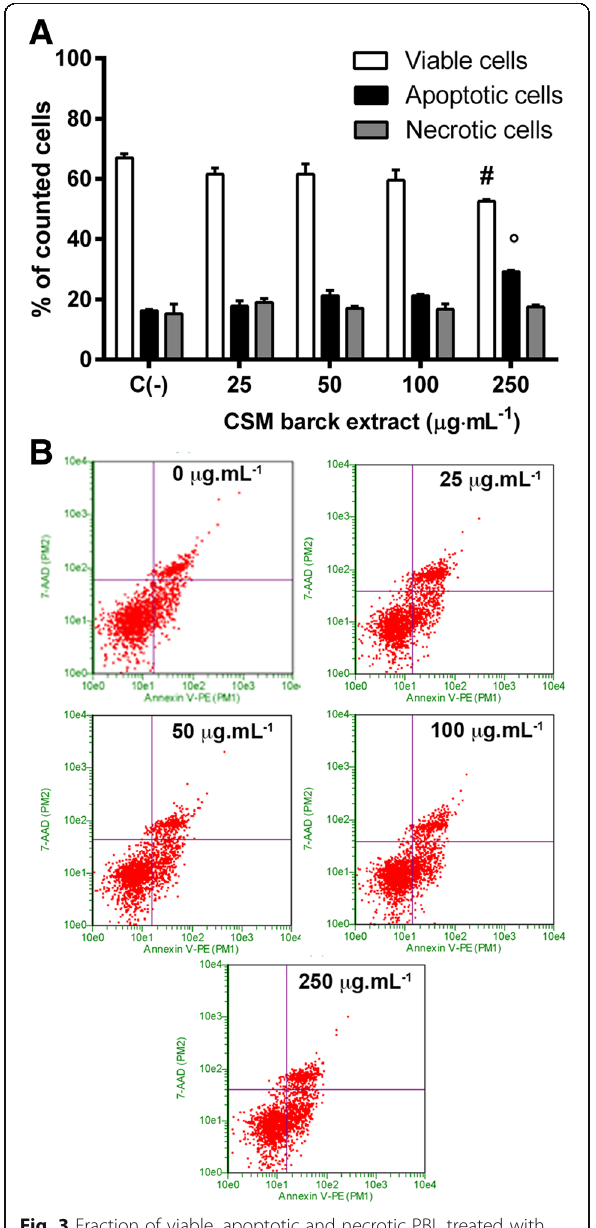
Fig. 3 Fraction of viable, apoptotic and necrotic PBL treated with CSM bark extract at the indicated concentrations for 24 h ( a ) and representative dot plot of apoptosis analysis at ( b ). Apoptosis was evaluated by FCM as described in Methods. Each bar represents the mean ± SEM of five independent experiments. Data were analyzed by repeated ANOVA followed by Bonferroni post-test. # p < 0.05 vs control viable cells, ° p < 0.05 vs control apoptotic